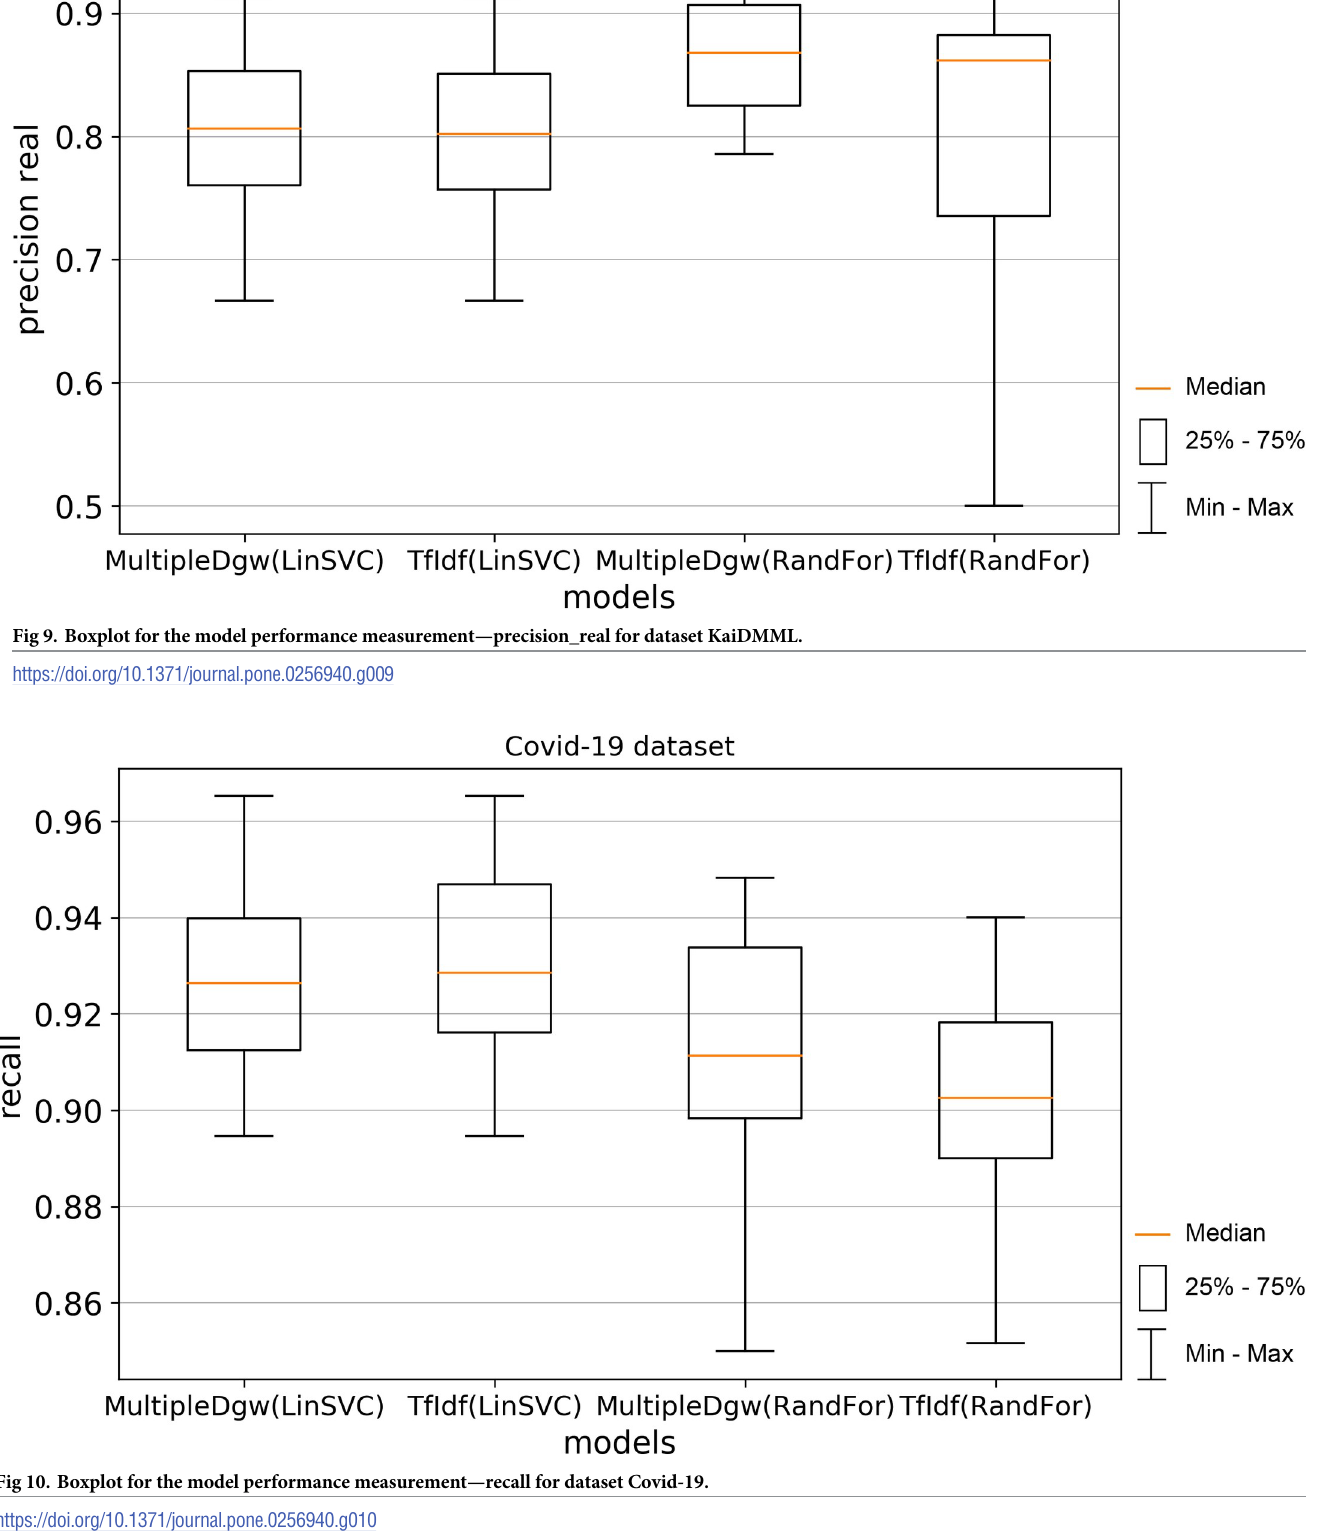
PLOS ONE | https://doi.org/10.1371/journal.pone.0256940 September 14,